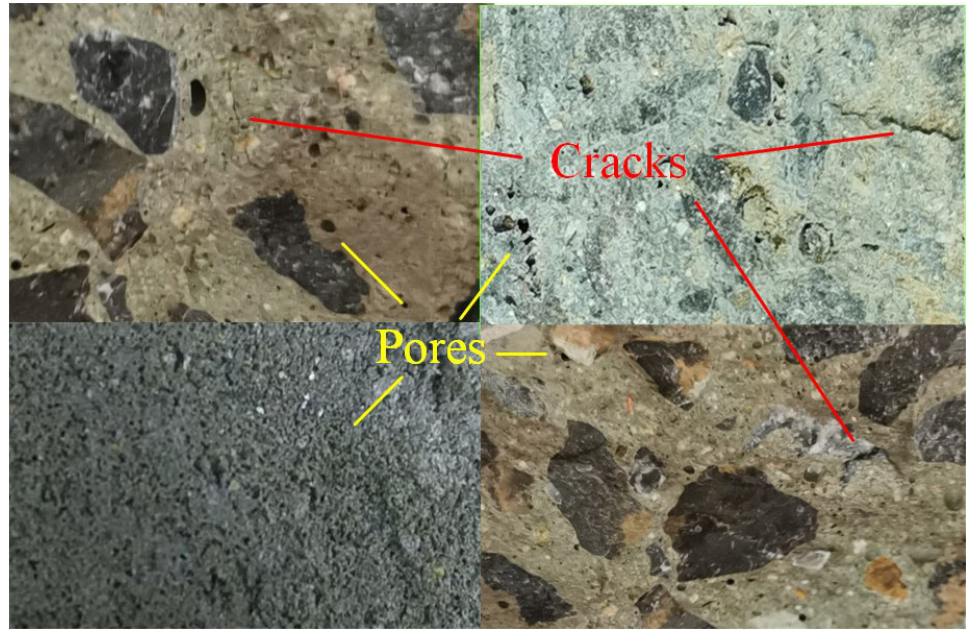
Figure 6. Pores and fissures on the samples.